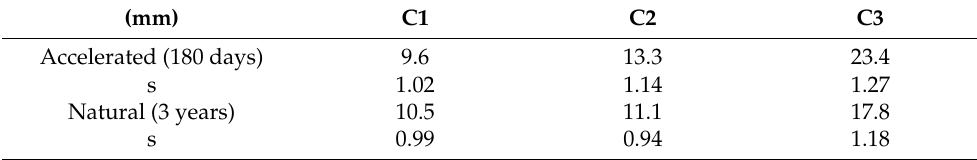
Table 14. Carbonation depth and standard deviation of C25/30 strength class mixtures.